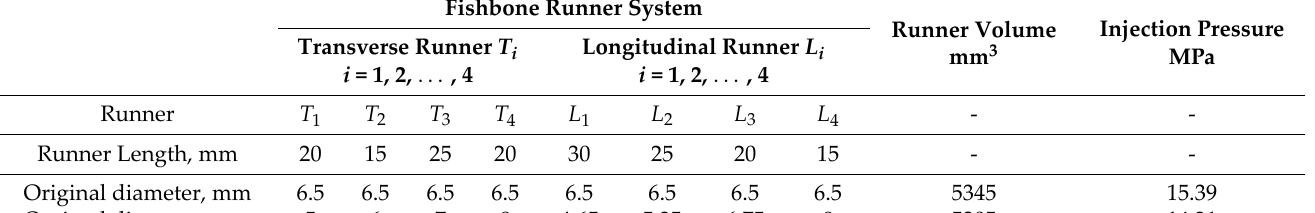
Figure 5. Illustration of 1/2 model of 8-cavity mold with an arbitrary runner layout.